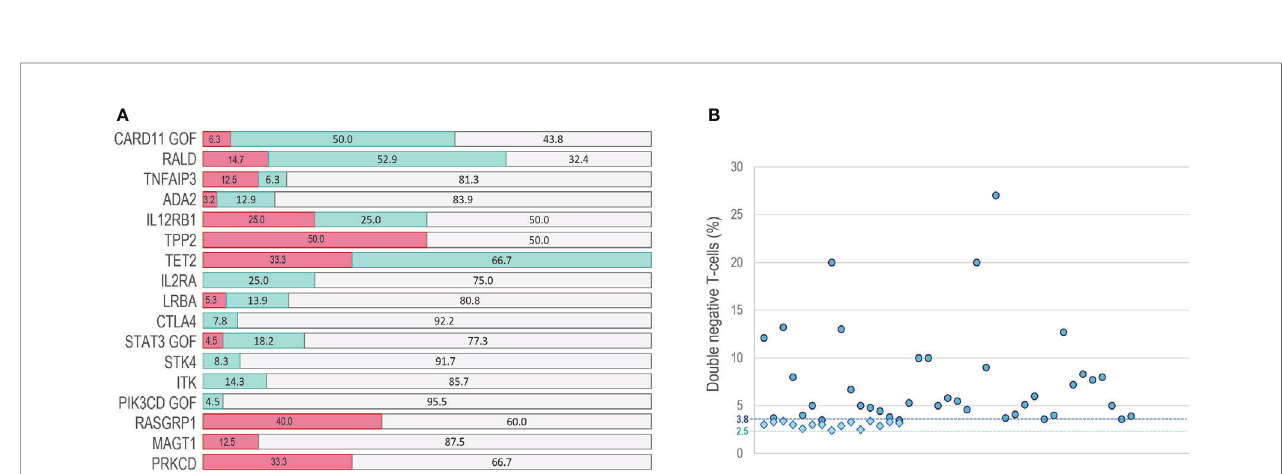
FIGURE 3 | DNT in ALPS-like patients. (A) percentage of patients with normal (red bars) increased (blue bars) or not reported (gray bars) values of DNT. (B) range of DNT percentage presented in patients with high DNT. Circles: percentage of DNT in CD3+TCR ab + lymphocytes. Rhombus: percentage of DNT in CD3+ lymphocytes. Dashed line at point 3.8: DNT cutoff in CD3+TCR ab + lymphocytes. Dashed line at point 2.5: DNT cutoff in